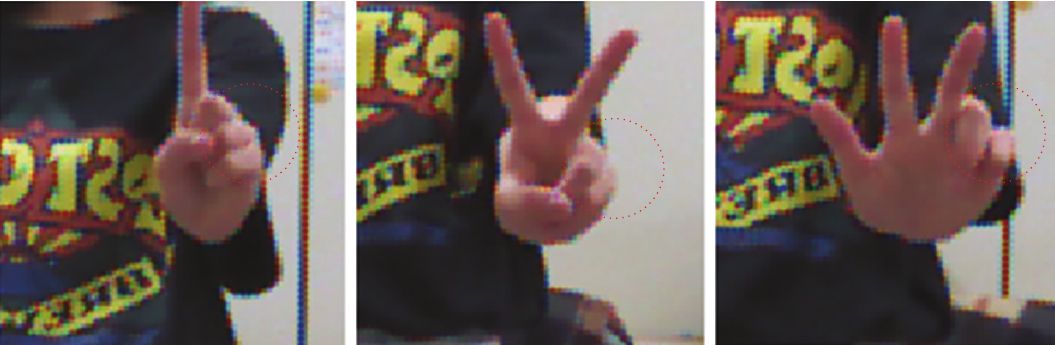
Figure 14: Shape comparison of folded ring and little fingers for one-, two-, and three-finger gestures.